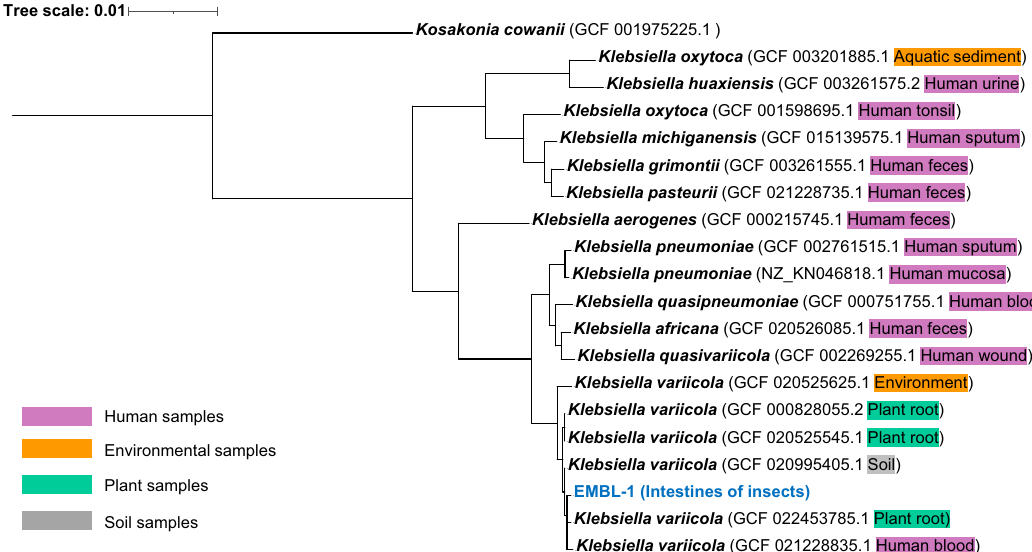
Fig. 3 | Genome-level phylogeny of strain EMBL-1. Phylogenetic tree of the strain EMBL-1 was built based on reference genomes from gtdbtk database and visualized with